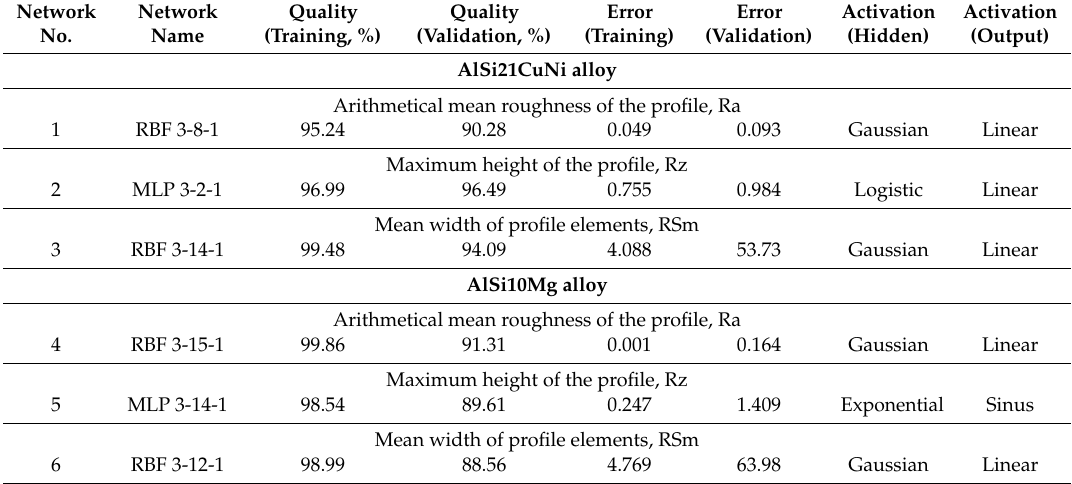
Table 7. Multi-layered perceptron (MLP) and radial basis function (RBF) networks for surface roughness parameters Ra, Rz, and RSm in AlSi21CuNi and AlSi10Mg alloys. Network